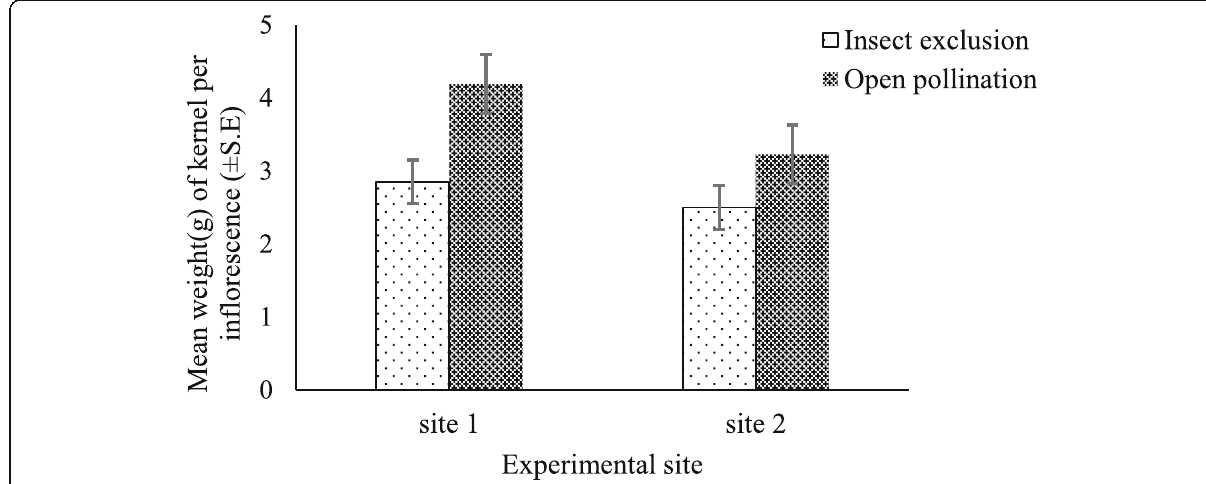
Fig. 5 Mean weight of dry shea kernels produced per inflorescence in the Guinea savanna zone of